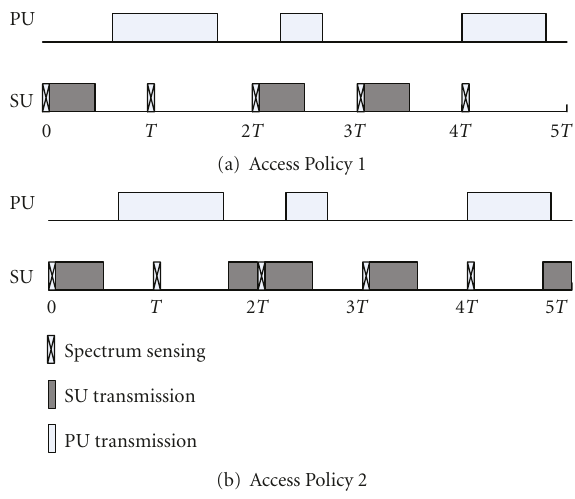
Figure 1: Illustration of the time behavior of PU and SU under two di ff erent access